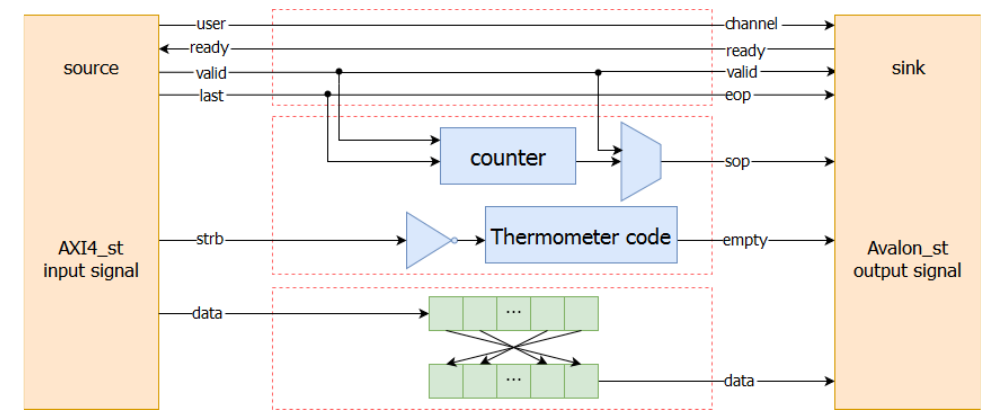
Figure 4. Bus protocol transformation